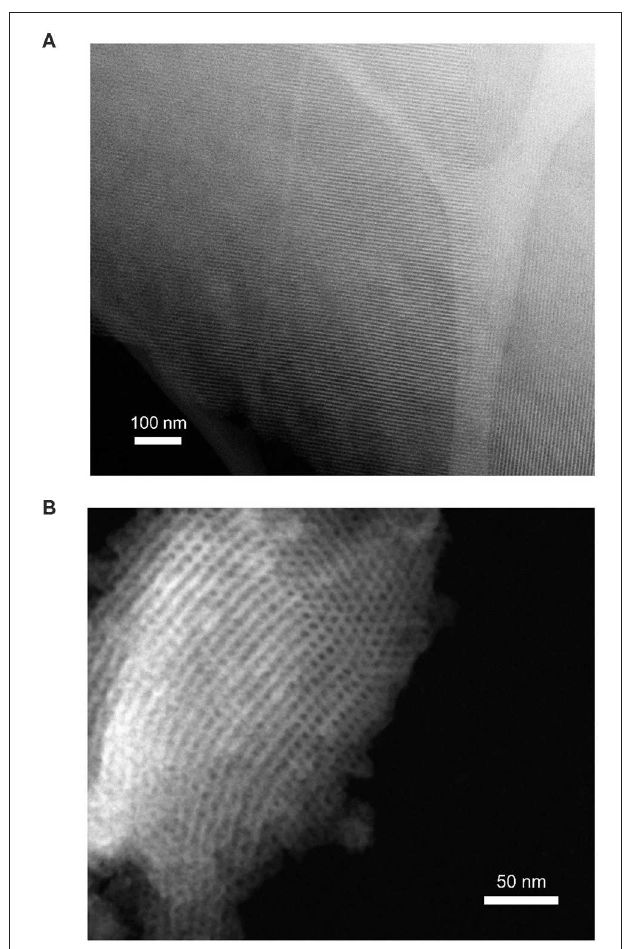
FIGURE 2 | Scanning TEM images of (A) SBA-16 and (B) FDU-5 showing nano-sized ordered mesoporous